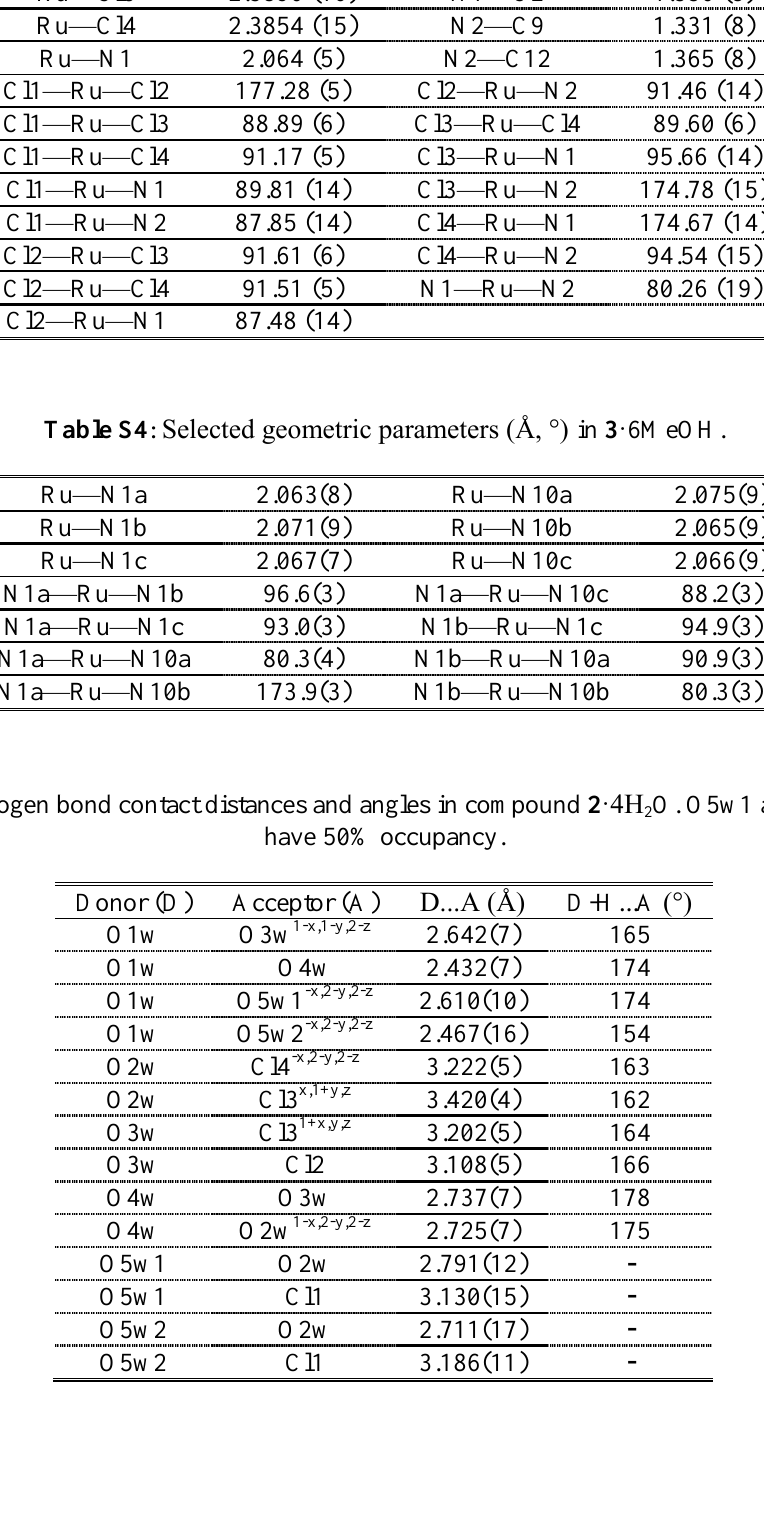
Table S3 : Selected geometric parameters (Å, °) in 2 ·4H